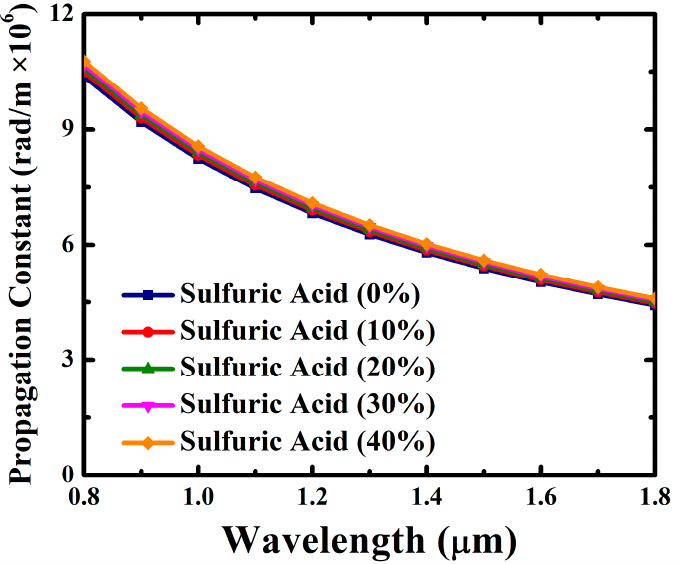
Figure 8. Propagation constant of the proposed PCF sensor with 0%, 10%, 20%, 30%, and 40% con- centrations of sulfuric acid for different operating